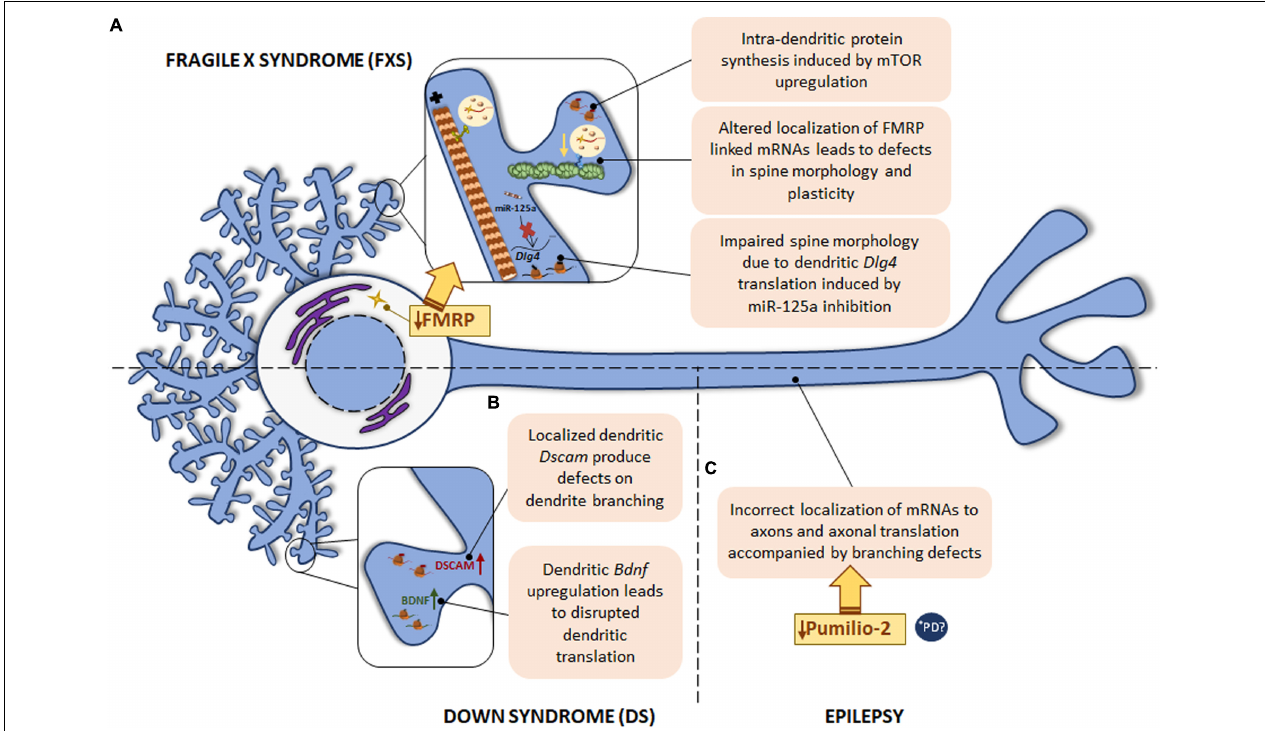
FIGURE 5 | Local translation defects in FXS, DS and epilepsy. (A) The most common monogenic cause of ASD is FXS, caused by a mutation in FMR1 gene with the consequent FMRP protein deficiency. FMRP regulates RNA metabolism at different levels and therefore, intra-dendritic translation is altered at several points: mTOR-mediated local protein synthesis is upregulated; deregulation of local mRNAs-linked to FMRP leads to abnormal spine morphology and plasticity; deregulation of miR-125a induces Dlg4 mRNA dendritic translation with spine morphology defects. (B) DS, caused by trisomy of chromosome 21, is characterized by defects in dendrite morphology, which can be due to the increased levels of Dscam and Bdnf mRNAs in dendrites. The localization of Bdnf to dendrites is also disrupted in psychiatric disorders. (C) In epilepsy, deficiency in the RBP Pumilio-2 results in incorrect localization of mRNAs to axons and increased overall intra-axonal translation with the consequent branching defects. * PD PINK1 and PARK2, involved in PD pathogenesis, regulate translation of mitochondrial proteins by displacement of Pumilio-2 and other RBPs. Due to the local role of Pumilio-2 in translation in developing axons, localized translation in PD could also be